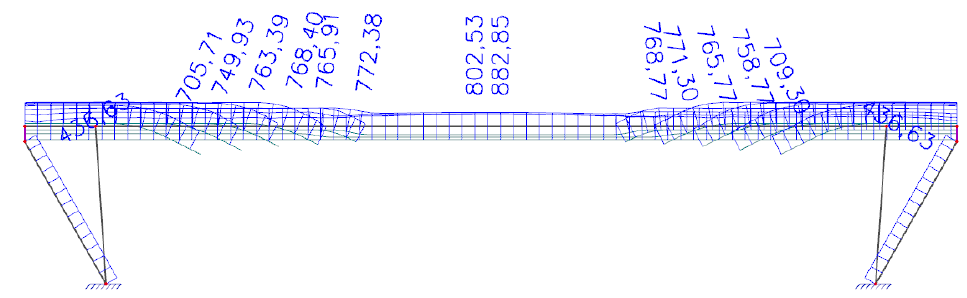
Figure 14. Stress [MPa] in tendons after 62 years of service.